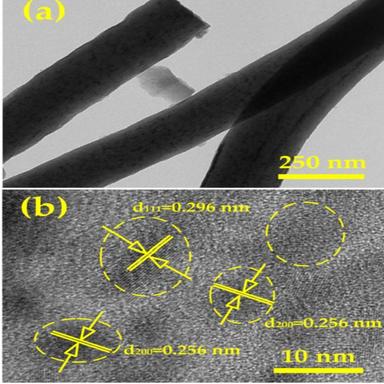
Representative TEM (a) and HR-TEM (b) images of CNFeZrO2-18 sample.